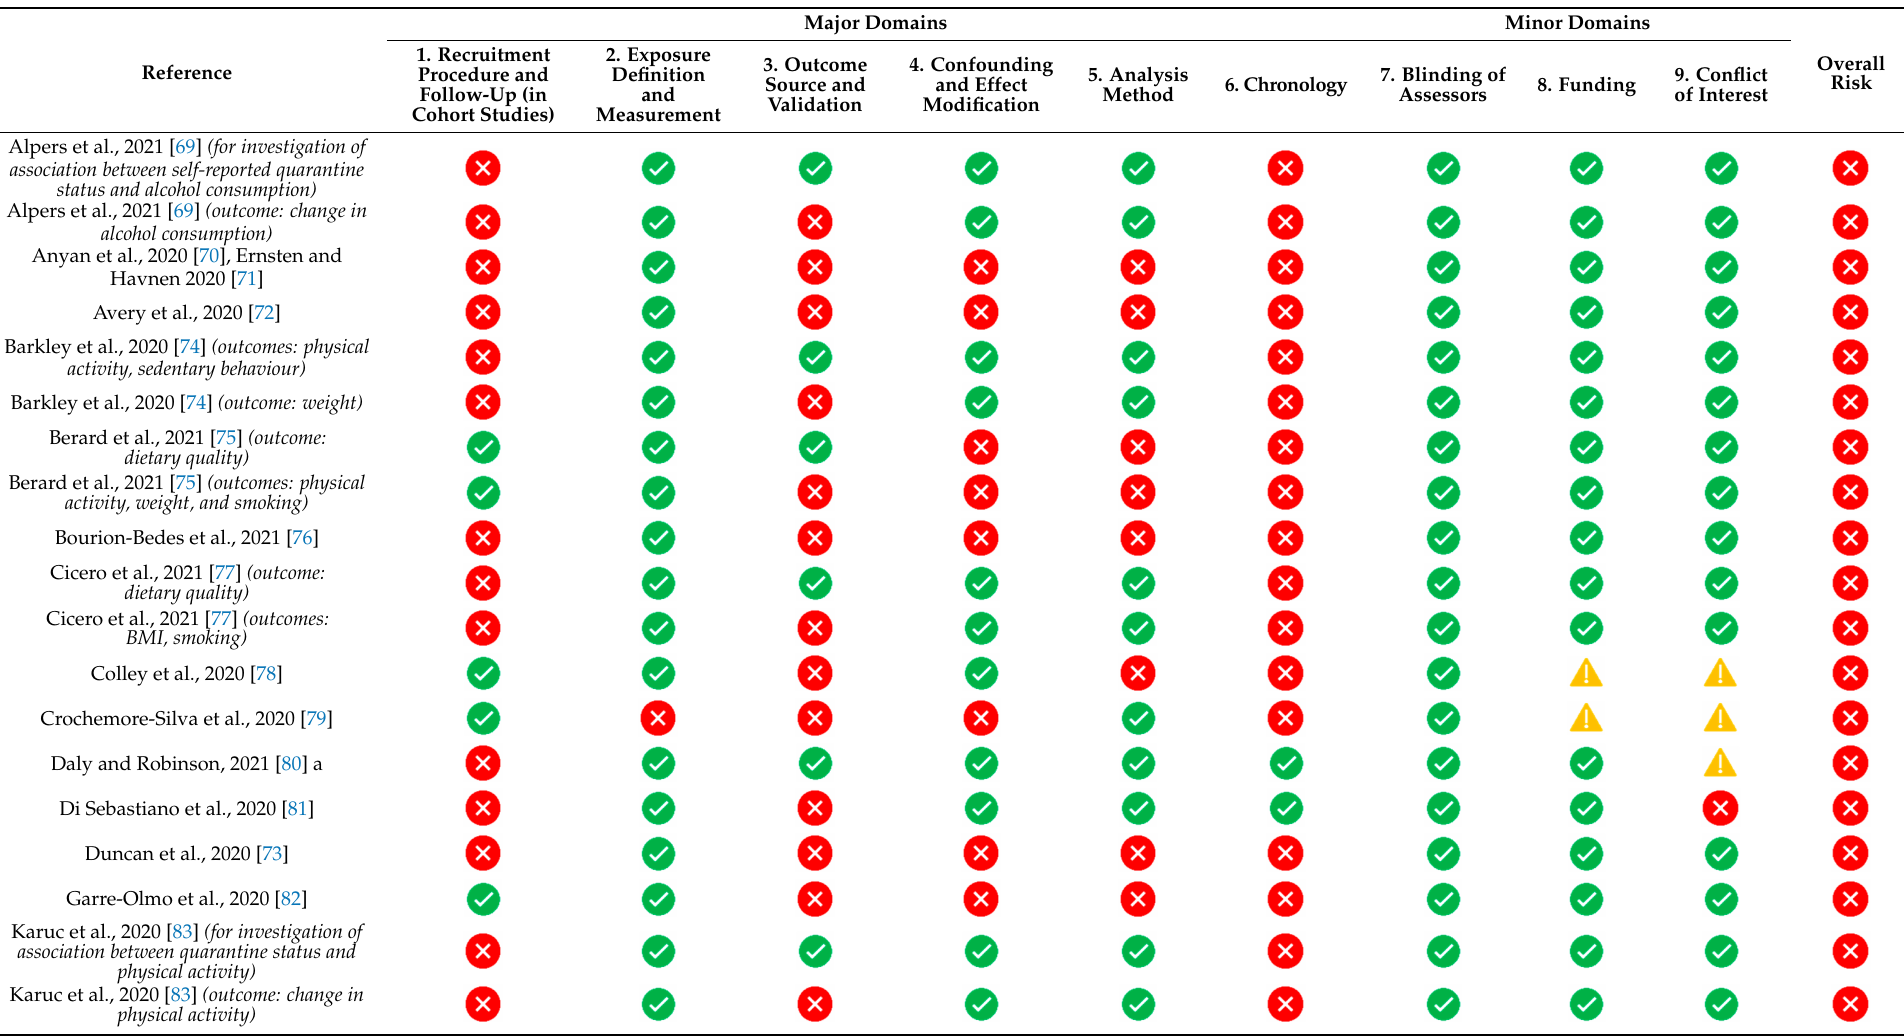
Table 3. Results of the risk of bias